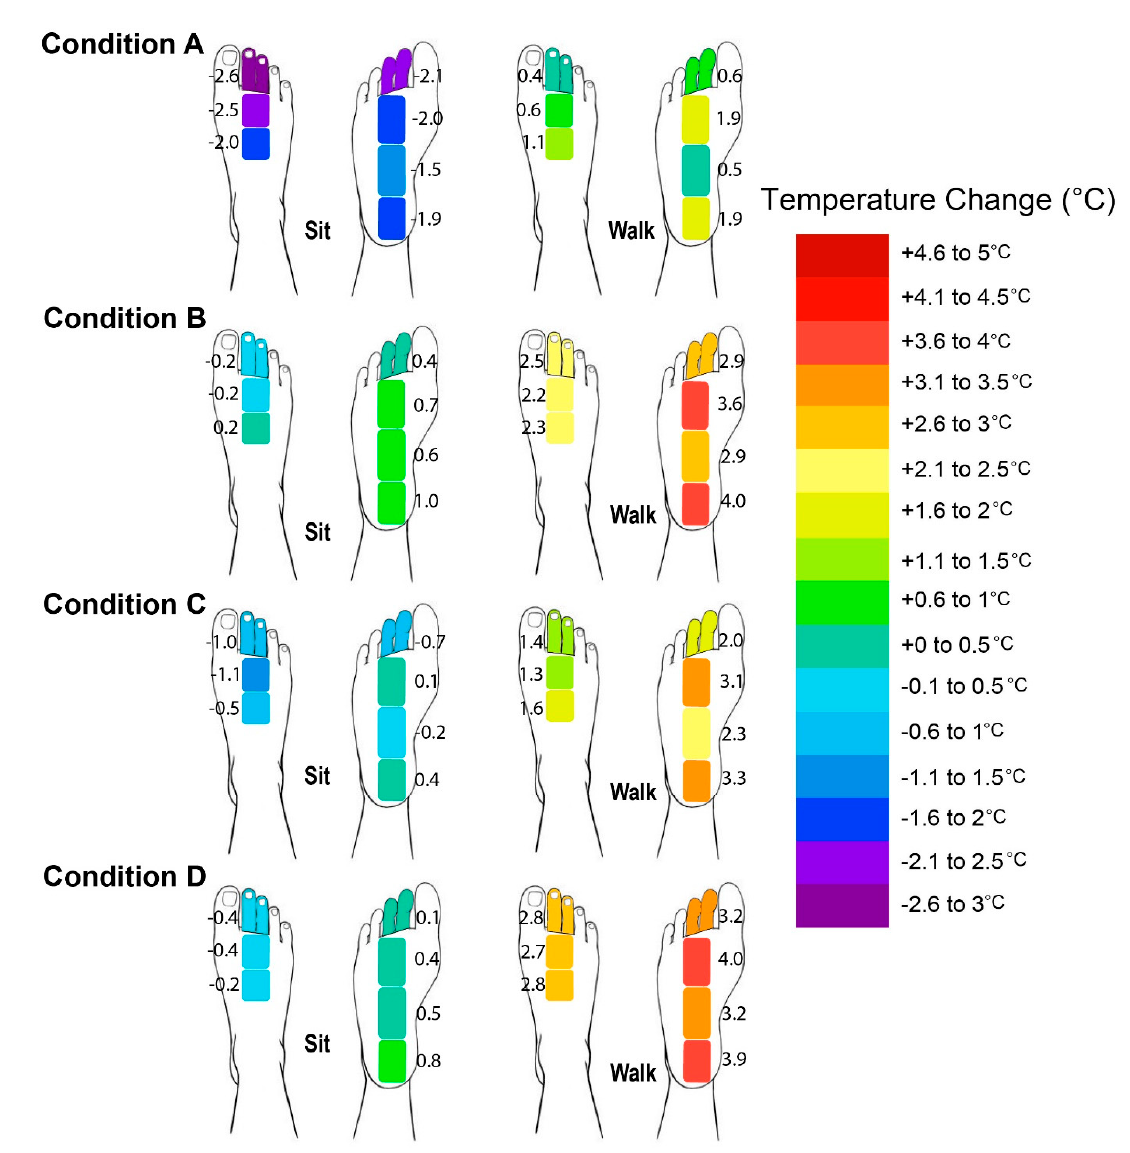
Figure 6. Changes in foot skin temperature of dorsal (TD1–TD3) and plantar sides (TP1–TP4) of foot based on four experimental conditions after sitting and walking, where A: barefoot, B: leather sports shoes, C: mesh sports shoes, and D: closed-toe slipper. Table 2. Summary of effects of different factors on changes in skin temperature, relative humidity, and sweat accumulation. Factor ( n = 40) Experimental Condition Length of Location Activity Gender A and B A and C A and D B and C B and D C and D Activity